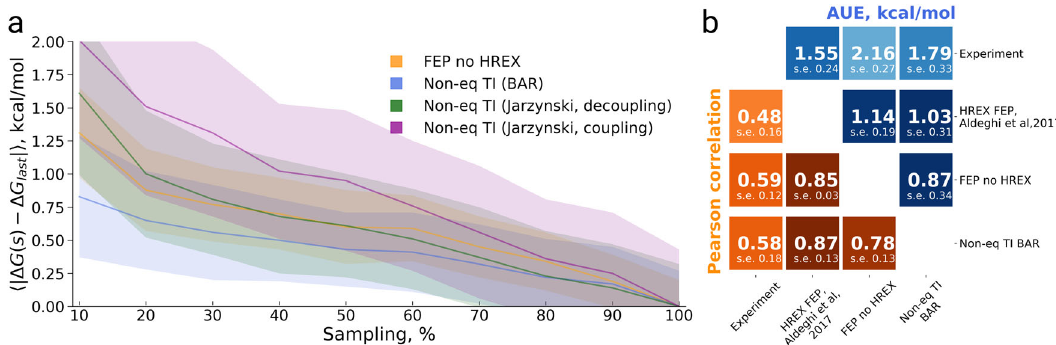
Fig. 6 Convergence analysis of absolute binding free energies for bromosporine binding to 22 bromodomains. a Bias with respect to the fi nal estimate using the whole available sampling against the invested sampling time. b Matrix comparing the calculation approaches, as well experimental measurement, in terms of Pearson correlation and average unsigned error (AUE). The uncertainties denote standard errors obtained by bootstrapping.